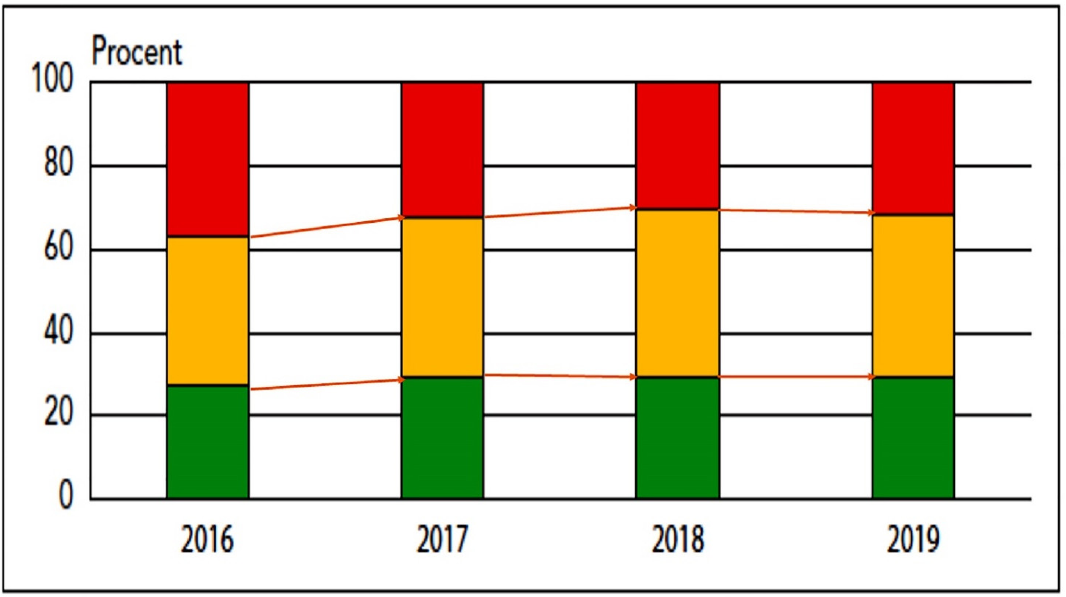
Figure 5. Summarized results in SI for 109 municipalities that participated in all surveys 2016–2019 [7].